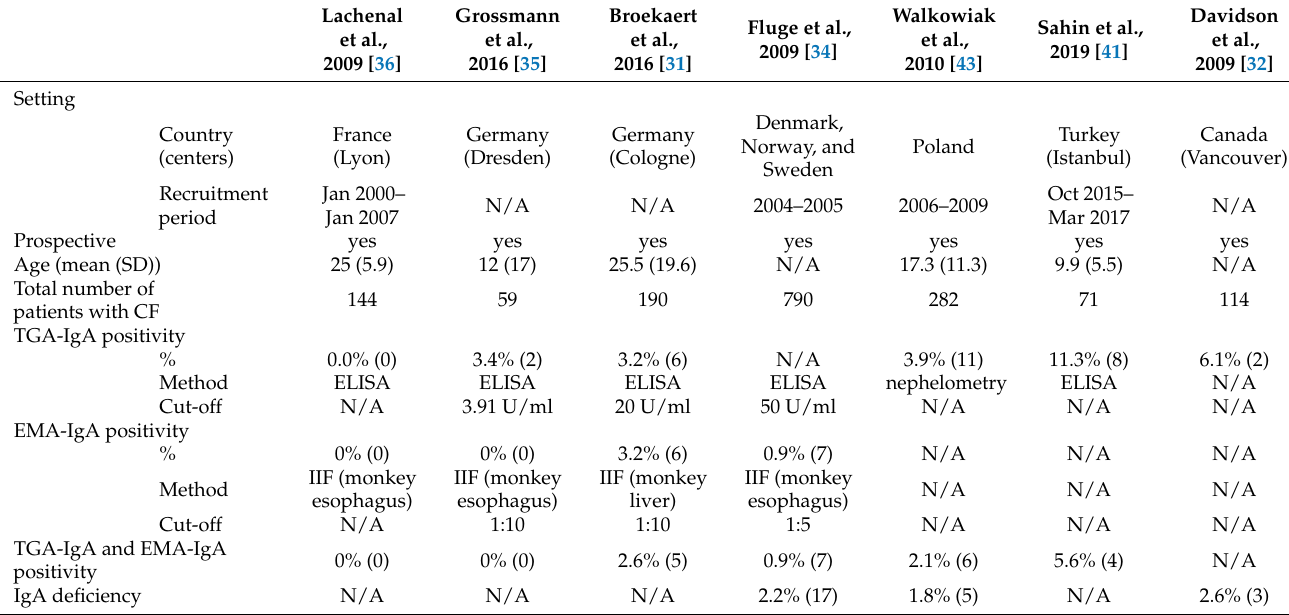
Table 3. CeD seroprevalence (SD: standard deviation, CF: cystic fibrosis, IIF: indirect